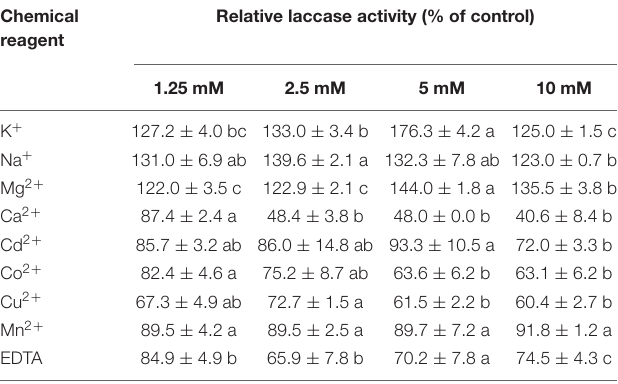
TABLE 4 | Effect of chemical reagents on the laccase activity of